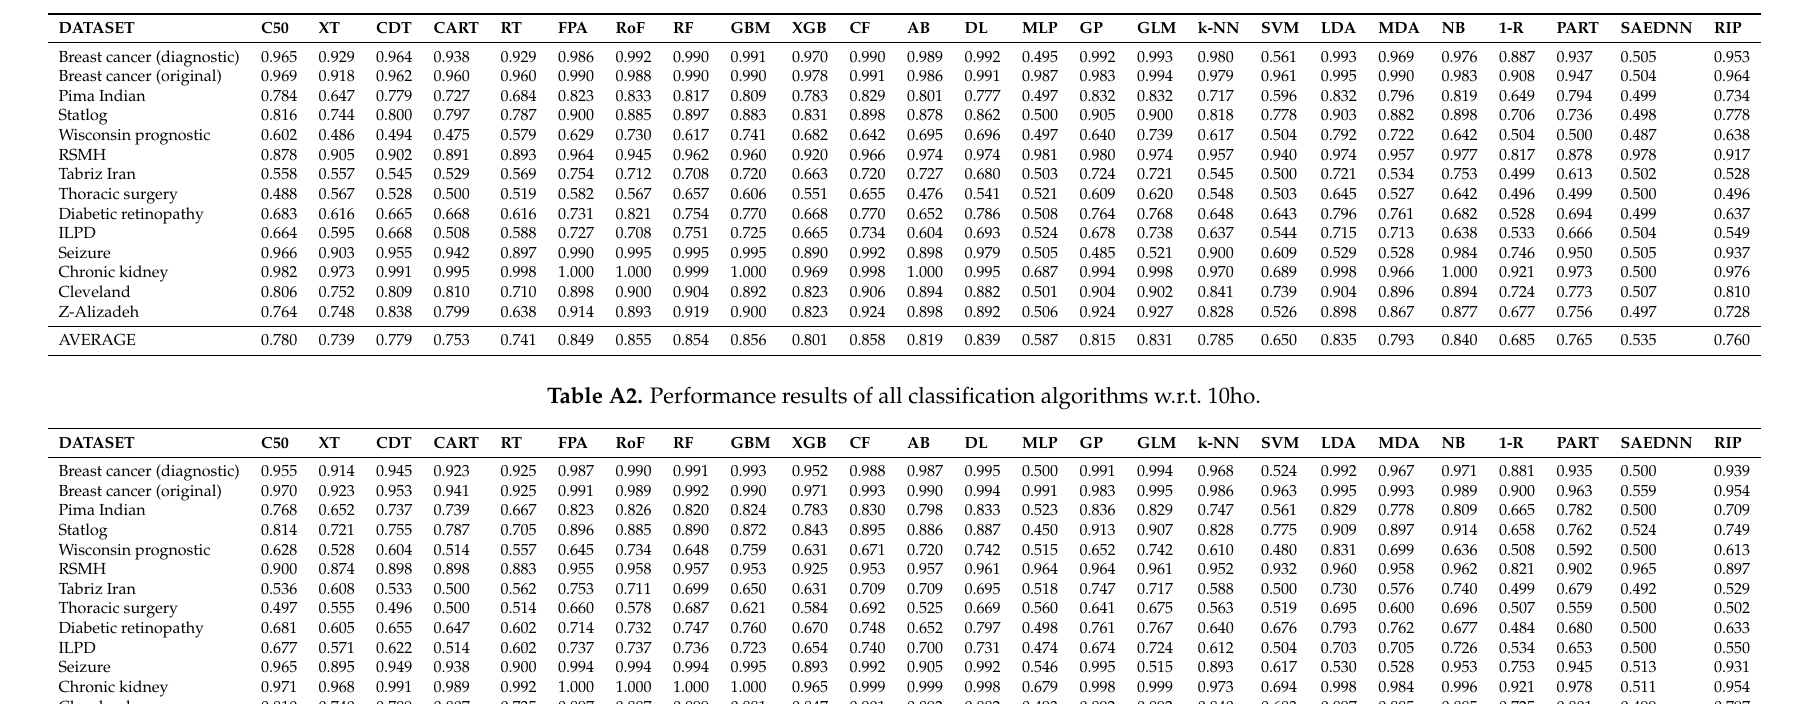
Table A1. Performance results of all classification algorithms w.r.t. 10cv.